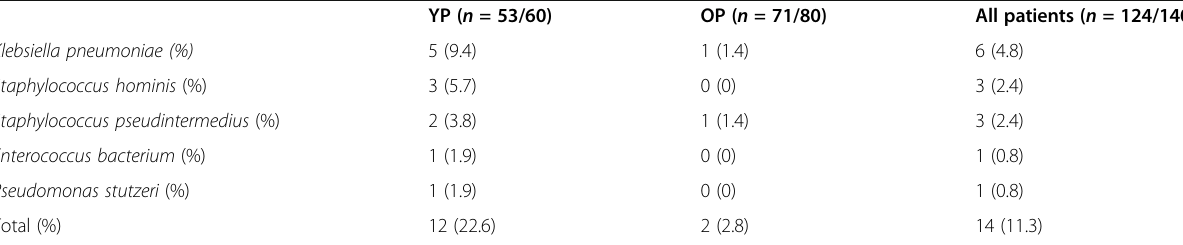
Table 3 Types of bacteria in each group